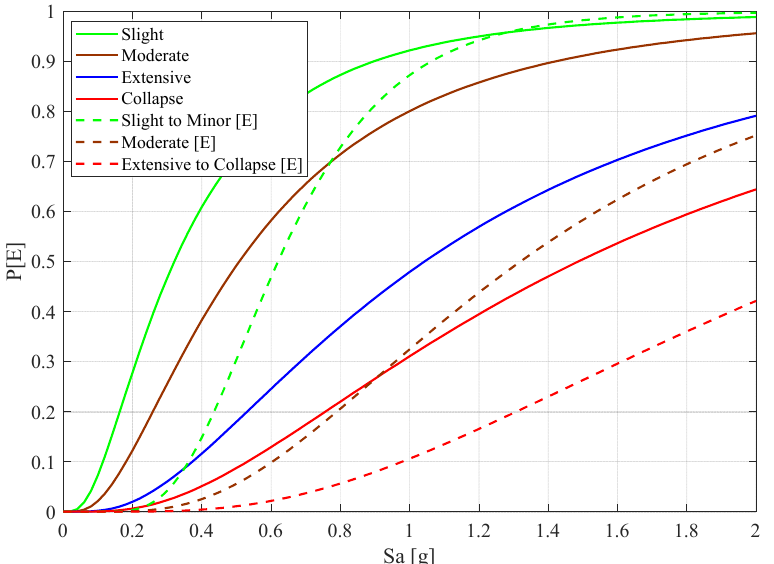
Figure 12. Fragility functions for low-rise RC building for infill model considering soil–structure interaction.